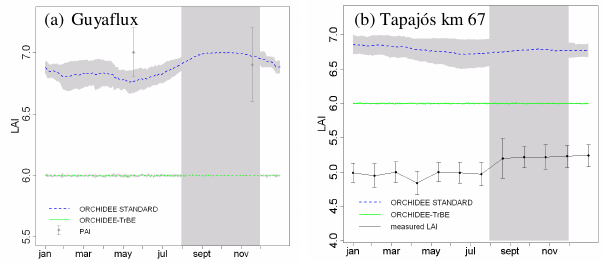
Fig. 5. LAI mean annual time profile plotted along with standard Figure 5. LAI mean annual time profile plotted along with standard deviation deviation (grey) at (a) Guyaflux 2004–2009 and (b) Tapaj´os (km (grey) at (a) Guyaflux 2004-2009 and (b) Tapajós km 67 2002-2004 for 67) 2002–2004 for standard ORCHIDEE and ORCHIDEE-TrBE. standard ORCHIDEE and ORCHIDEE-TrBE. The dry period (<100 mm The dry period ( < 100mmmonth − 1 ) is shaded. For Guyaflux, field month -1 ) is shaded. For Guyaflux, field estimates of the mean plant area index estimates of the mean plant area index (PAI, m 2 m − 2 ) made at 16– (PAI, m 2 m -2 ) made at 16–18 May 2005 and 16–18 November 2005 based on 40 18 May 2005 and 16–18 November 2005 based on 40 measurements measurements within inventory plots around the flux tower using LAI2000 within inventory plots around the flux tower using LAI2000 sensors sensors (Bonal et al., 2008) are plotted. For Tapajós km 67, mean seasonal (Bonal et al., 2008) are plotted. For Tapaj´os (km 67), mean seasonal variation from December 2003 to November 2004 measured using LAI-2000 variation from December 2003 to November 2004 measured using LAI-2000 Plant Canopy Analyser (Malhado et al., 2009) is Plant Canopy Analyser (Malhado et al., 2009) is plotted.